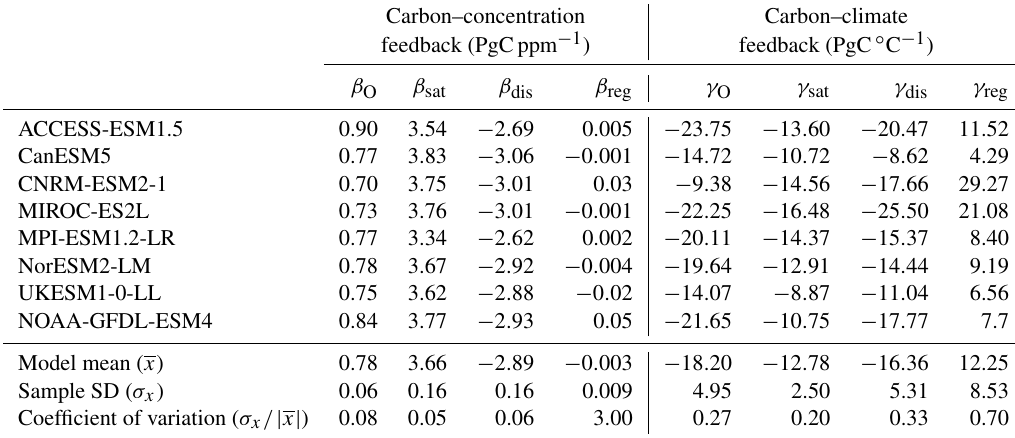
Table A3. Carbon cycle feedback parameters for the ocean, β O and γ O , diagnosed from the air–sea carbon fluxes and separately diagnosed for the ocean carbon inventory and its separate ocean saturated, disequilibrium, and regenerated DIC pools for the subset of eight CMIP6 models for which 3D ocean data were available; their sum does not exactly match the diagnostics from the air–sea fluxes due to land–ocean interactions involving storage in sediments and river